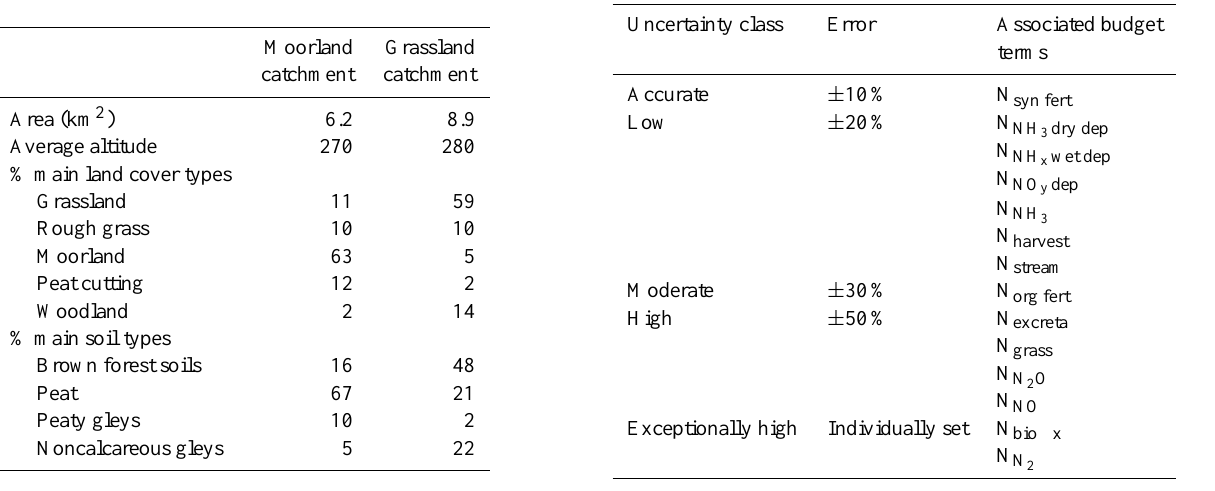
Table 2. Uncertainty